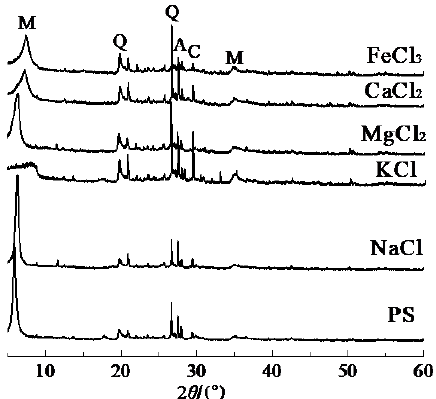
Figure 7. XRD of modified PS samples based on different modifiers. Q, Quartz (SiO 2 ); C, Calcite (CaCO 3 ); M, Montmorillonite (Ca 0.2 (Al,Mg)Si 4 O 10 (OH) 2 ·4H 2 O); A, Albitc (NaAlSi 3 O 8 ).